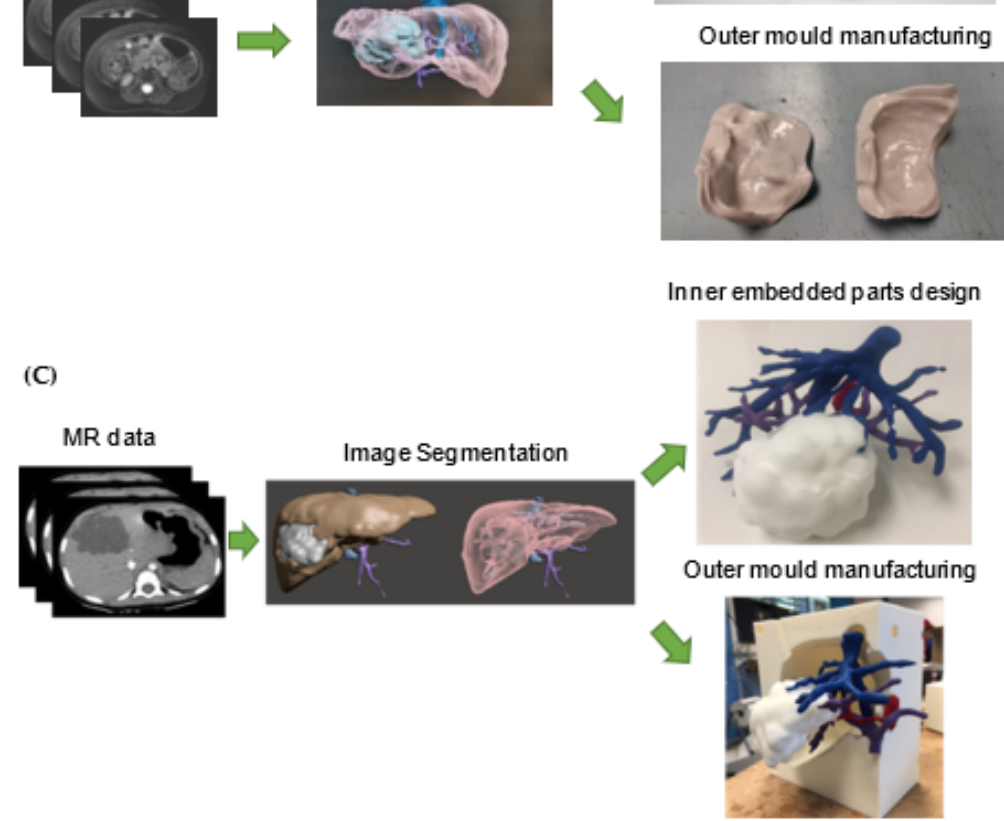
Figure 6. Work fl ow for the design of the 3D model. ( A ) Case #1. ( B ) Case #2. ( C ) Case #3. Figure 6. Workflow for the design of the 3D model. ( A ) Case #1. ( B ) Case #2. ( C ) Case